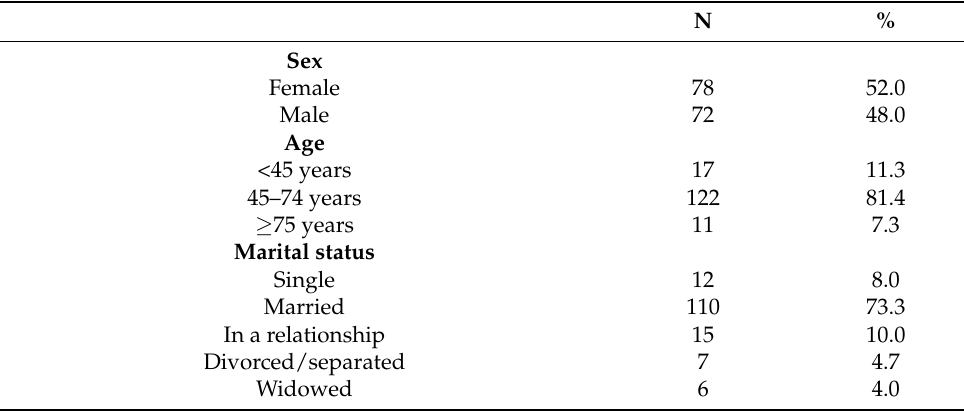
Table 1. Sociodemographic and medical